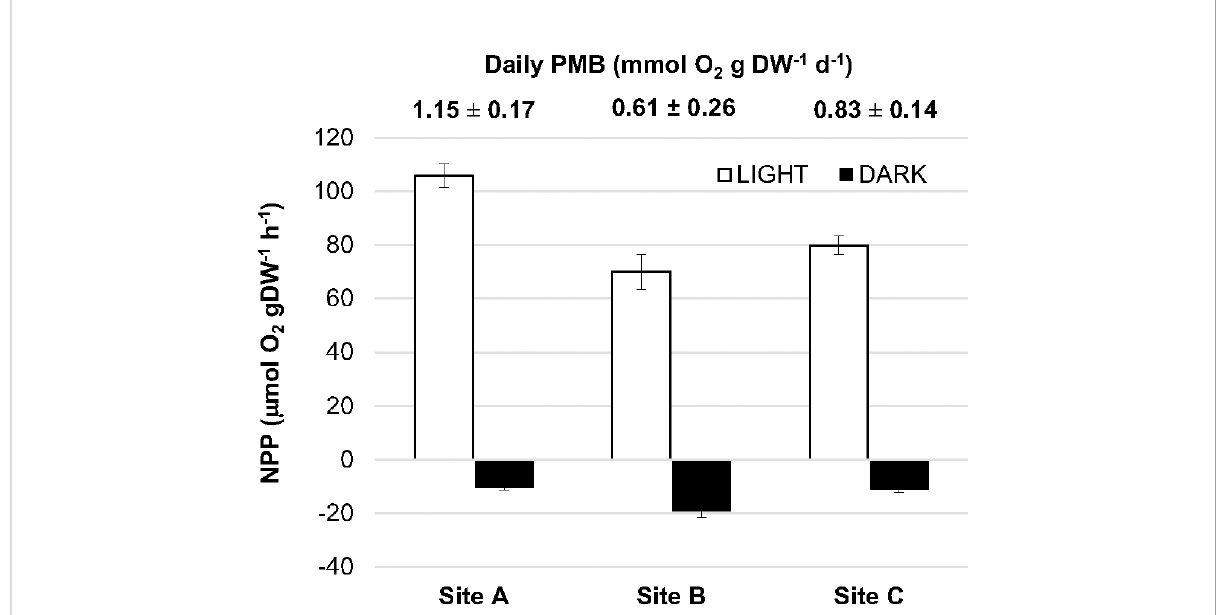
FIGURE 2 Net plant oxygen production of S. isoetifolium measured in light (net plant productivity, NPP, white columns) and in darkness (respiration, R, black columns) at “ Saint-Gilles ” (STG, site A), “ Passe Ermitage ” (PAS, site B) and “ Saline ” (SAL, site C). Bars are mean ± SEM. Numbers above indicate the daily plant metabolic balance (PMB) for each site (mean ±